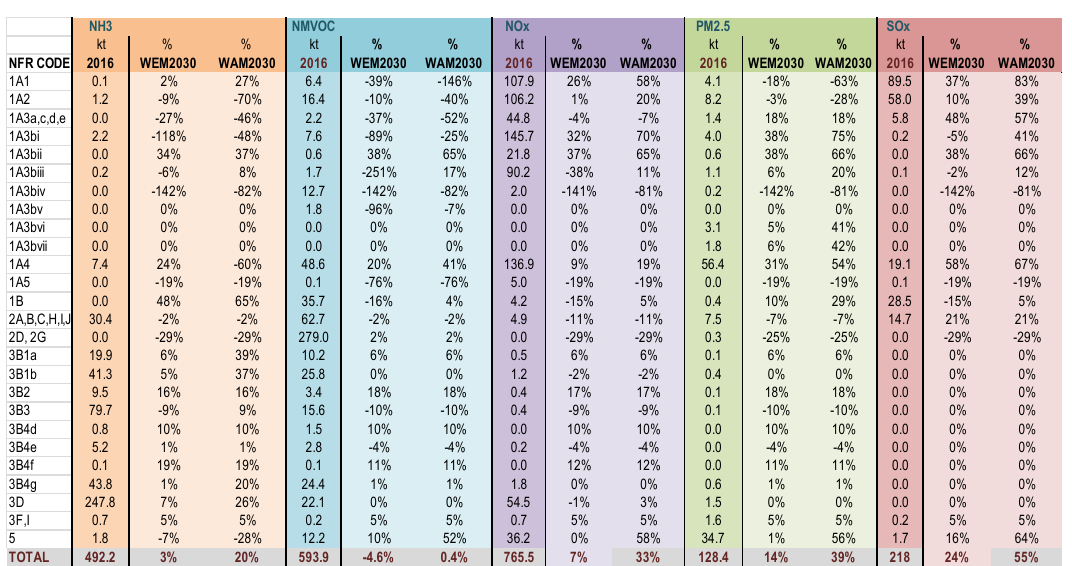
Figure A3. Emissions in 2016 (kt/year) and reduction of emissions (%) for the measures included in WEM2030 and WAM2030 scenarios for the NFR (nomenclature for reporting) source categories (described in Appendix D), relative to 2016.